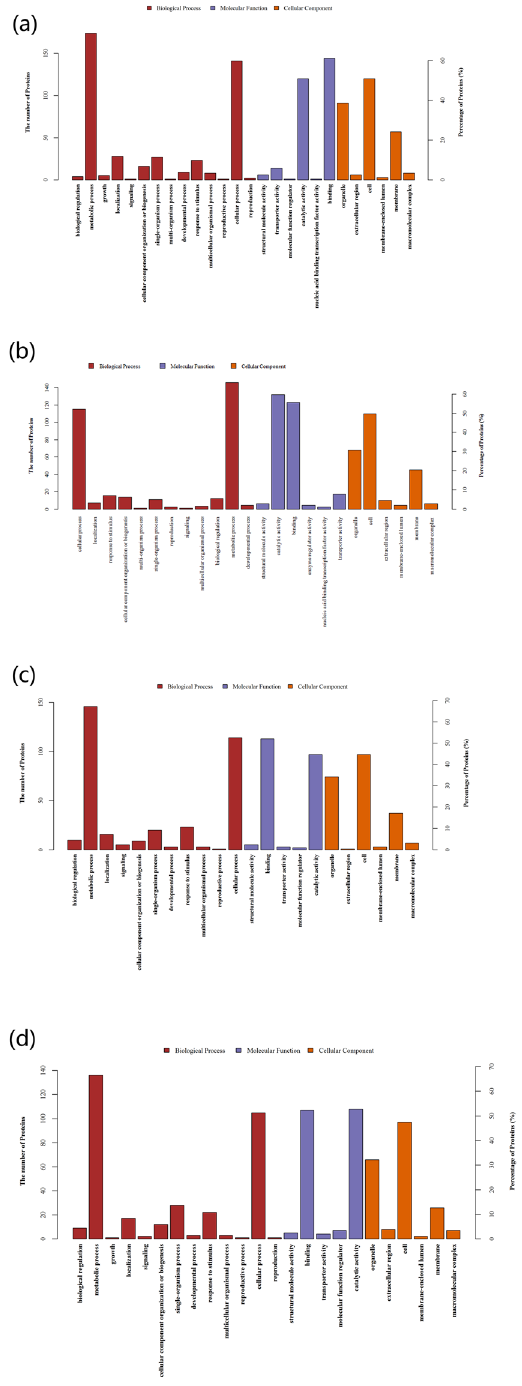
Figure 2. Gene Ontology (GO) annotation of the differentially abundant protein species. ( a ) 70 vs. 100 DAF in ‘Tianyuanhong’ (group B/A). ( b ) 70 vs. 100 DAF in ‘Yongfengyihao’ (group D/C). ( c ) 70 DAF in ‘Tianyuanhong’ vs. ‘Yongfengyihao’ (group A/C). ( d ) 100 DAF in ‘Tianyuanhong’ vs. ‘Yongfengyihao’ (group